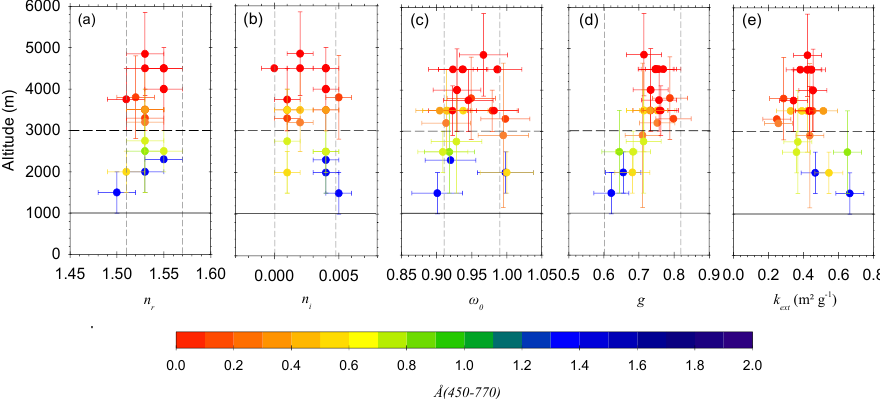
Figure 8. Scatter plots showing (a) the real part of the complex refractive index n r , (b) the imaginary part of the complex refractive index n i , (c) the single scattering albedo ω 0 , (d) the asymmetry parameter g and (e) the mass extinction efficiency of aerosols k ext all at λ = 530nm as a function of the altitude from all SLRs and vertical profiles within the dust layers measured during the campaign. The altitude indicated for vertical profiles refers to the middle of the layer. Horizontal error bars display the uncertainties of the parameters. Vertical error bars indicate the altitude range used to calculate each data point. Broad classifications of the above-3 km dust layer and the below-3km dust layer are shown in horizontal lines. Vertical dashed lines indicate the range of values obtained in dust source regions. The maximum value of k ext reported in the literature for dust in source regions is above 0.8m 2 g − 1